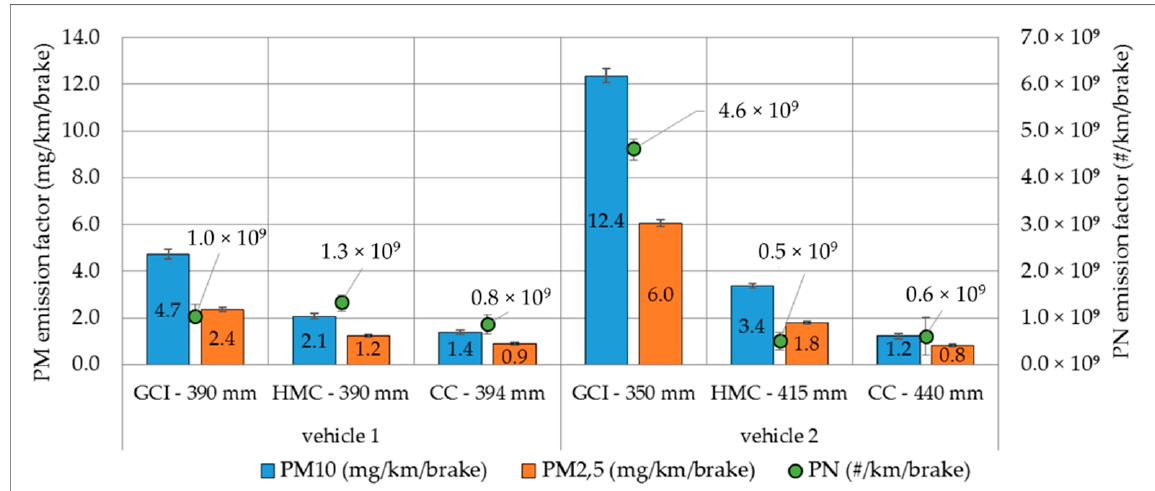
Figure 10. Number- and mass-related emission factors of the tested disc concepts (Vehicles 1 and 2)—WLTP brake cycle trip #10.